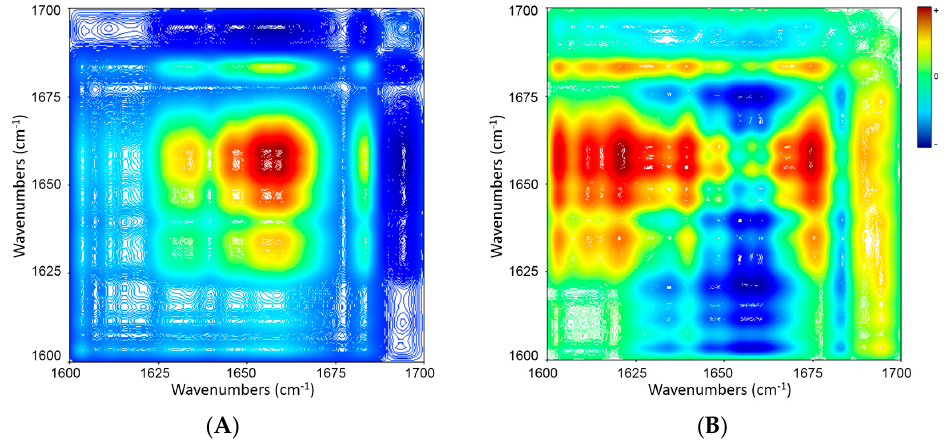
Figure 6. 2D IR synchronous ( A ) and asynchronous ( B ) maps of amide I bands of ICFs (5% w / v in D 2 O) during cooling (70 → 5 °C, in decrement of 5 °C). Red and blue color represent positive and negative correlation peaks, respectively.